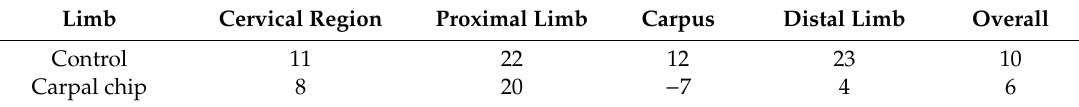
Table 18. MNT values (% change from baseline) measured 2 weeks post carpal chip induction [30].